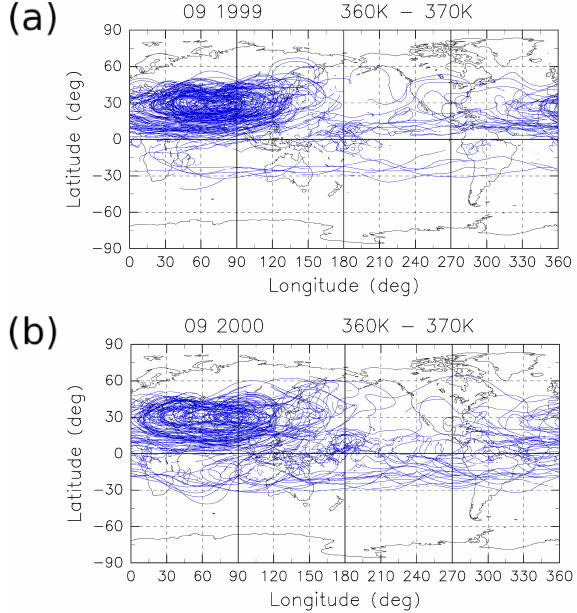
Figure 4. Horizontal projection of the backward trajectories ex- tracted within the potential temperature levels between 360 and 370K. The initialization is made at 400K potential temperature sur- face between 30 ◦ N and S from the Equator (Sect. 2) in (a) Septem- ber 1999 and (b) September 2000. The illustration is limited to the subset of trajectories as in Fig. 1 for visual